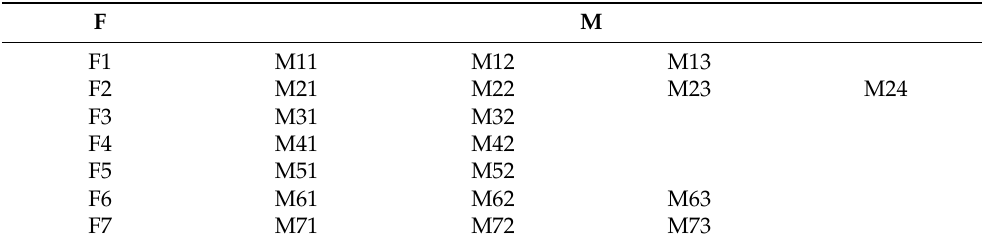
Table 2. Original conceptual design morphological chart of the transmission